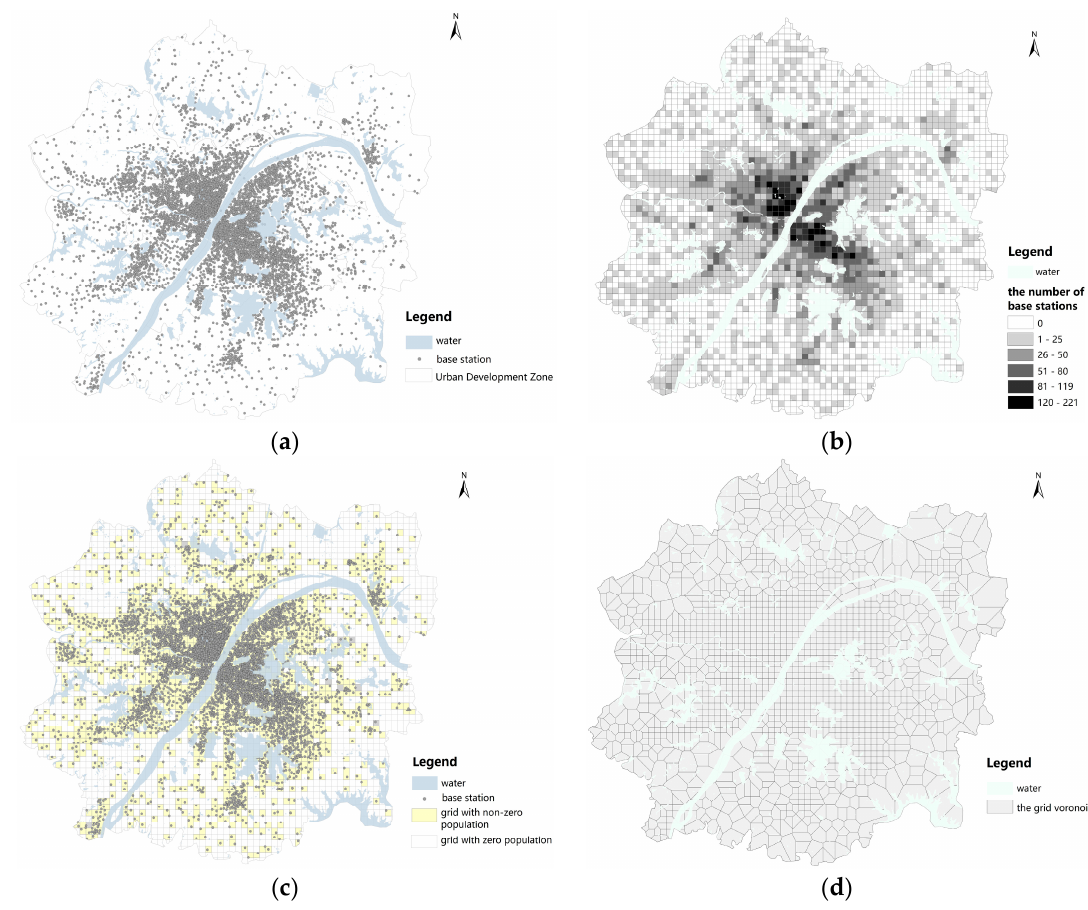
Figure 3. Process mapping of obtaining Grid Voronoi service area: ( a ) base station data; ( b ) number analysis of the gridded base station; ( c ) gridded base station data; ( d ) the Grid Voronoi.